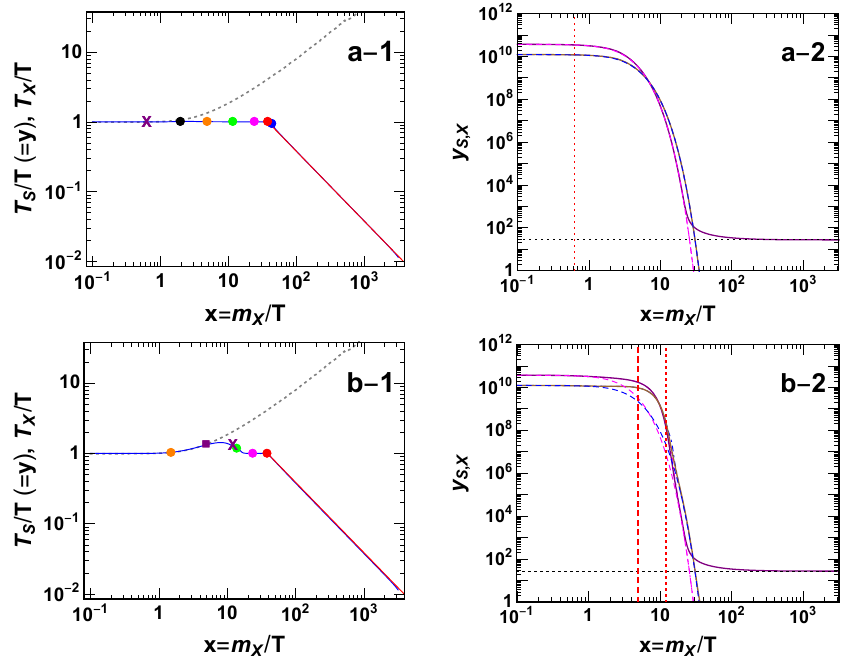
Figure 3 . Left panel: T S =T and T X =T versus m X =T , where T is the bath temperature. As T is below that denoted by the red dot, T X =T follows the red line. The DM freeze-out temperature is denoted by the magenta dot. For T below that denoted by black and orange dots, the hidden sector cannot keep the thermal equilibrium with the bath via the inverse S annihilation and S -SM elastic scattering, respectively, while for T below that denoted by the blue dot, S is completely thermally decoupled from the bath. When T is below that denoted by the purple \X" (corresponding to the vertical dotted (red) line in the right panel), the heating rate due to the inverse decay of S can be larger than that needed to keep the hidden sector in thermal equilibrium with the bath. The purple square (corresponding to the vertical dashed (red) line in the right panel) stands for the temperature below which the S undergoes an out-of-equilibrium decay. When T falls below that denoted by the green dot, the heating rate of the cannibal process in the hidden sector is less than H . The conservation of the comoving hidden sector entropy is described by the dotted curve (see eq. (5.9)). Right panel: y X (purple solid line) and y S (brown solid line) as functions of x , where the magenta and blue dashed (or dashed-dotted) lines show the corresponding yields if following Boltzmann suppression with T S;X = T (or with their true temperatures). The horizontal line denotes the asymptotic DM yield, y 1 . Here we use m X = 80 GeV, m S = 64 GeV, and, in (a) and (b), separately X adopt (cid:11) = 1 (cid:2) 10 (cid:0) 5 and 1 (cid:2) 10 (cid:0) 6 . The value g dm is determined to have the correct relic